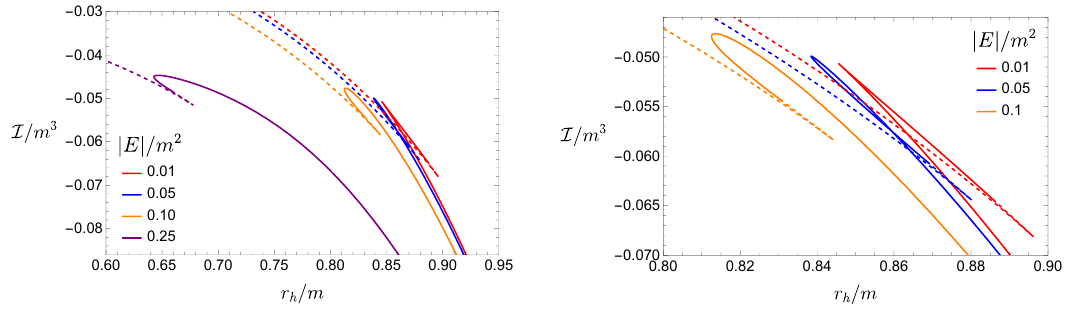
Figure 12 . On-shell Euclidean action for different values of the electric field. Solid (dashed) lines correspond to BH (Minkowski)